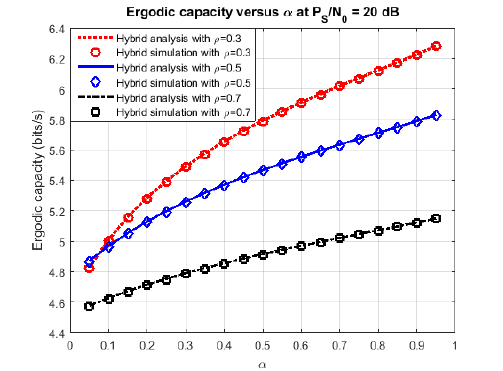
Fig. 10: Ergodic capacity of hybrid TSR-PSR versus α